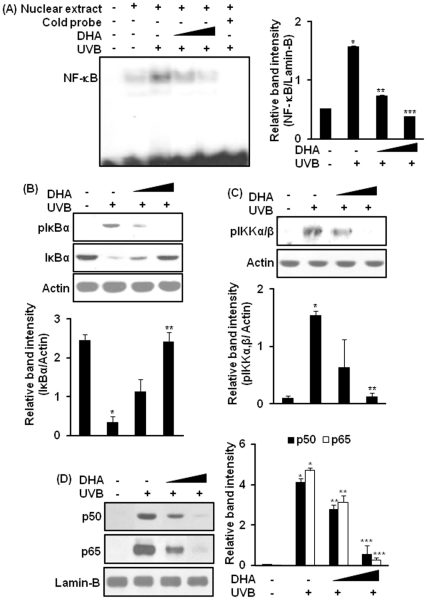
DHA inhibits UVB-induced activation of NF-κB in mouse skin.Female HR-1 hairless mice (n = 3 per treatment group) were treated topically with DHA (2.5 or 10 µmol/mouse) dissolved in 0.2 ml acetone. After 40 min, animals were exposed to UVB radiation (180 mJ/cm2). Control animals were treated with acetone and were not exposed to UVB. Animals were sacrificed 1.5 h post-UVB irradiation. The epidermal nuclear extract was prepared as described in Materials and Methods and analyzed by the EMSA. (A) Effects of DHA on UVB-induced NF-κB DNA binding. Representative data showing probe only (lane 1), vehicle control (lane 2), UVB alone (lane 3), 2.5 µmol DHA plus UVB (lane 4), 10 µmol DHA plus UVB (lane 5), and nuclear extract from UVB-treated skin plus 100-fold excess unlabeled NF-κB oligonucleotide (lane 6). *,
p<0.001 (vehicle only versus UVB); **,
p<0.01 (UVB versus 2.5 µmol DHA plus UVB); ***,
p<0.001 (UVB versus 10 µmol DHA plus UVB). (B) Cytosolic extract was prepared as described in Materials and Methods and subjected to Western blot analysis to determine the expression of total and phosphorylated IκBα. *,
p<0.001 (control versus UVB); **,
p<0.001 (UVB versus 10 µmol DHA plus UVB). (C) Epidermal lysate was analyzed for phosphorylation of IKKα/β (serine 181) by immunoblot analysis. *,
p<0.001 (control versus UVB); **,
p<0.001 (UVB versus 10 µmol DHA plus UVB). (D) Epidermal nuclear extract was assayed for nuclear localization of p50 and p65. *,
p<0.001 (control versus UVB); **,
p<0.05 (UVB versus 2.5 µmol DHA plus UVB); ***,
p<0.001 (UVB versus 10 µmol DHA plus UVB).